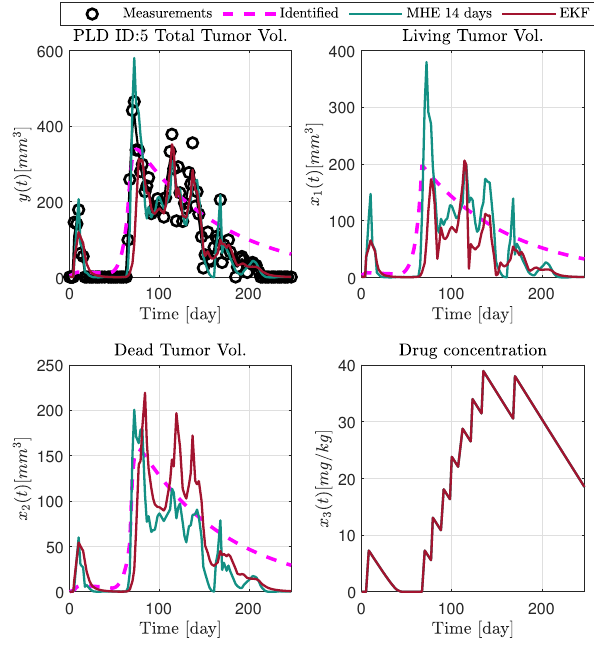
Figure 5. Estimated states of PLD5 mouse.